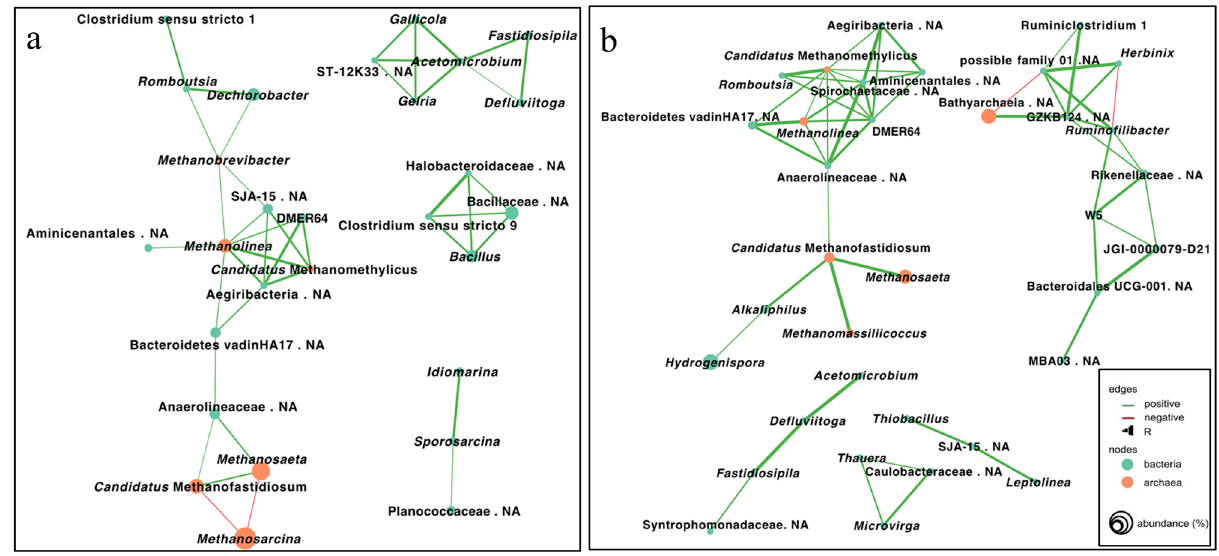
Figure 3. Co-occurrence network analysis based on the correlation of the relative abundance of amplicon sequence variant (ASV) reads for the microbial profiles at the genus level or the closest classified taxonomic level. ( a ) after the drying-rewetting and ( b ) incubation events. Bacterial and archaeal groups are shown by nodes in green and orange, respectively. Each edge represents significant correlations between pairs of nodes ( p ≤ 0.001), where positive and negative correlations are coloured in green and red, respectively. The thickness of the edge is proportional to the R value of the correlation (R ≥